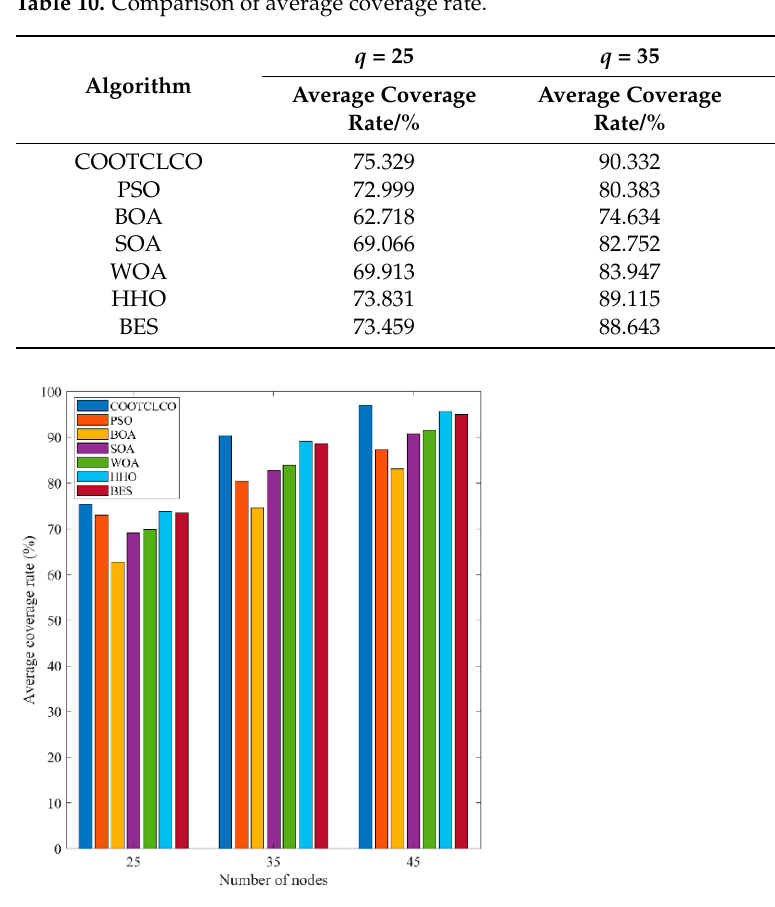
Figure 13. Comparison of the average coverage rate curves of the seven algorithms in the three cases: ( a ) q = 25, Rs = 10 m, Iteration = 1500; ( b ) q = 35, Rs = 10 m, Iteration = 1500; ( c ) q = 45, Rs = 10 m, Iteration = 1500.